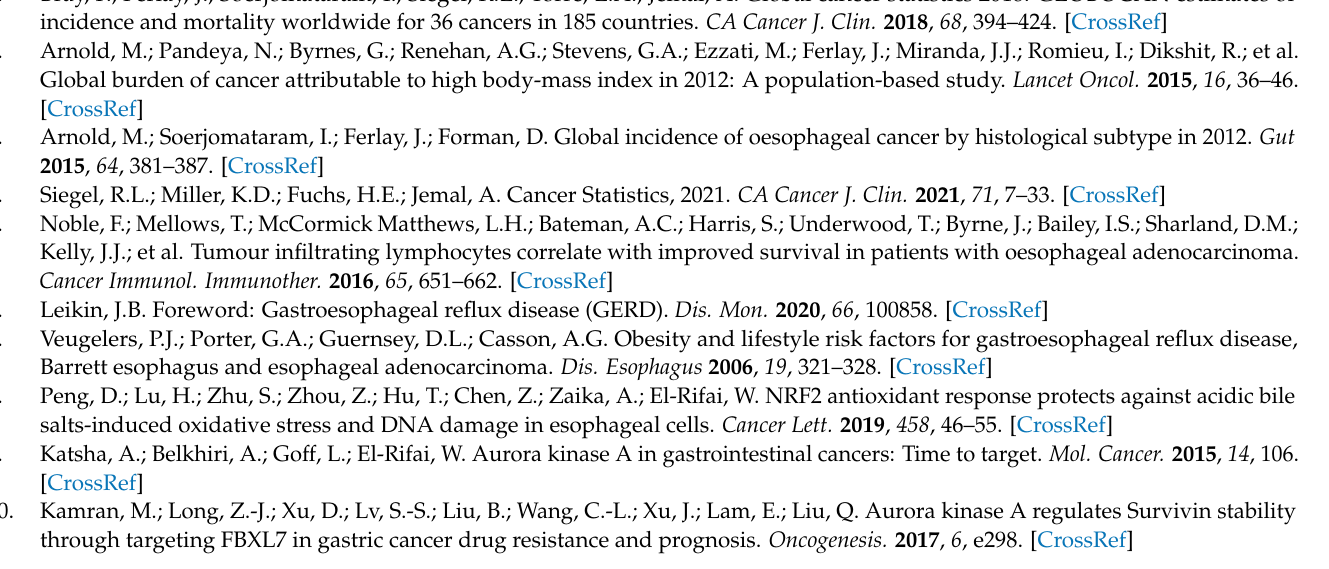
Table S2. Primers for q-RT-PCR.